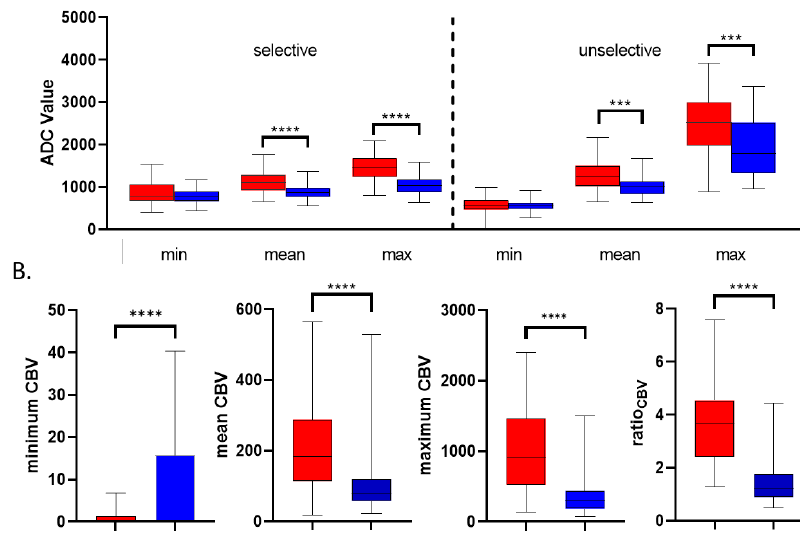
Figure 2. Box plot analysis of ADC and CBV measurement in GBM and PCNSL patients. ( A ) Box plot of apparent diffusion coefficient analysis of selective and unselective minimum, mean and maximum ROI measurement in patients with GBM (red) and PCNSL (blue). ( B ) Box plot of DSC CBV imaging analysis in patients with GBM (red) and PCNSL (blue). p values less than 0.05 were considered statistically significant. *** p < 0.001, **** p < 0.0001.